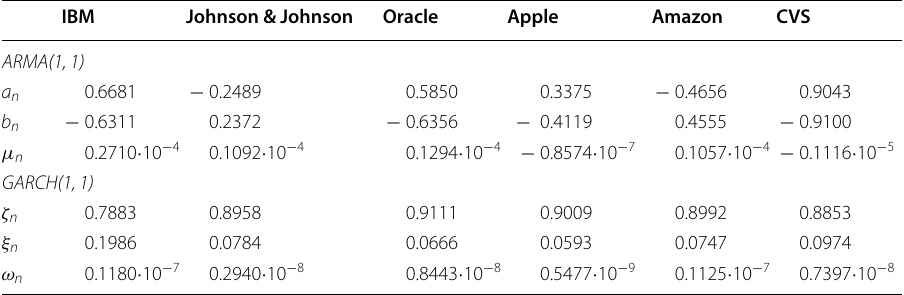
Table 1 Estimated parameters of ARMA–GARCH models with standard normal innovations